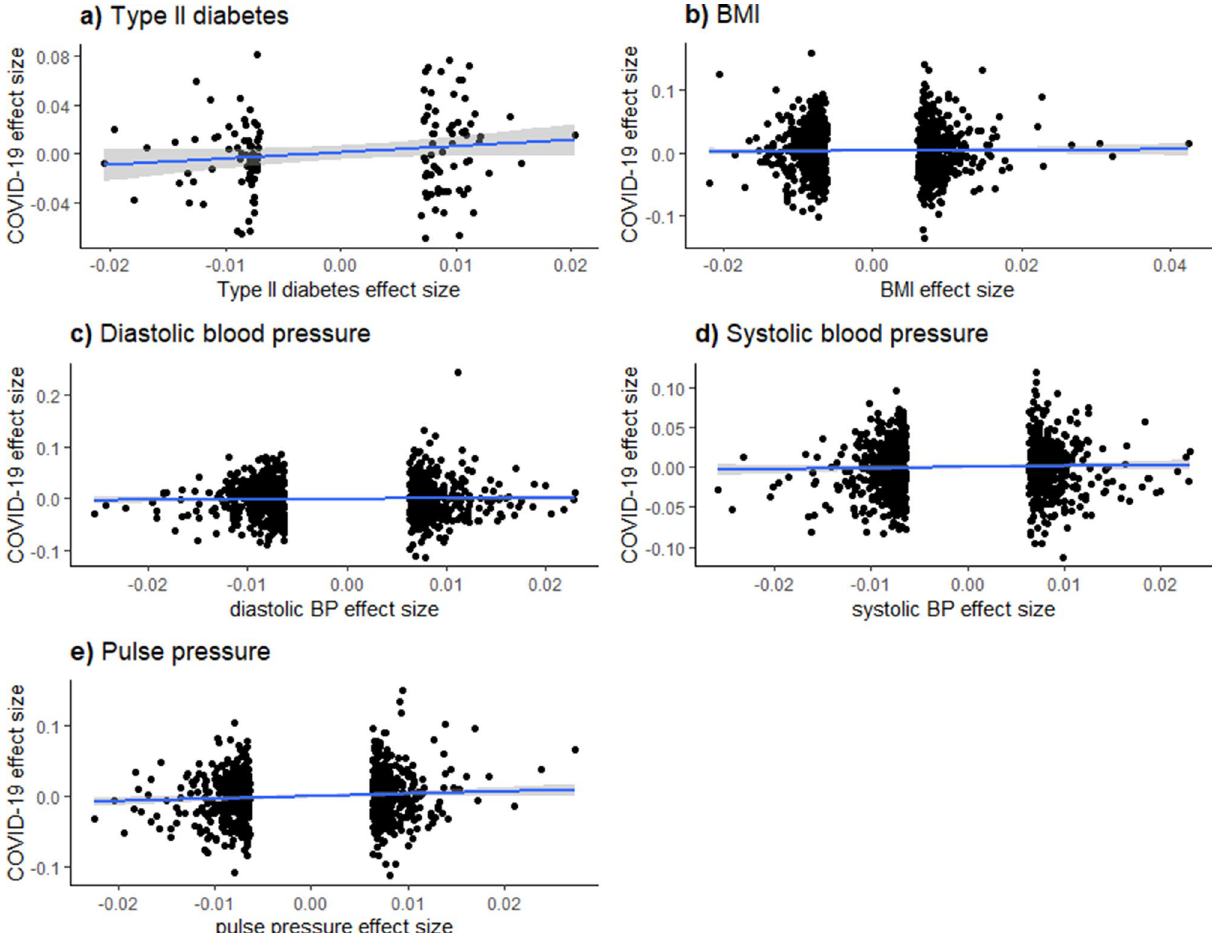
Figure 1. Exposure, COVID-19 Effect size associations—mixed ethnicity sample. These figures display the effect size associations between each exposure (Type II Diabetes, BMI, diastolic and systolic blood pressure, and pulse pressure) and COVID-19 hospitalization risk. Overlaid on the scatterplots are univariate linear regression fitted values and their associated 95% confidence intervals.